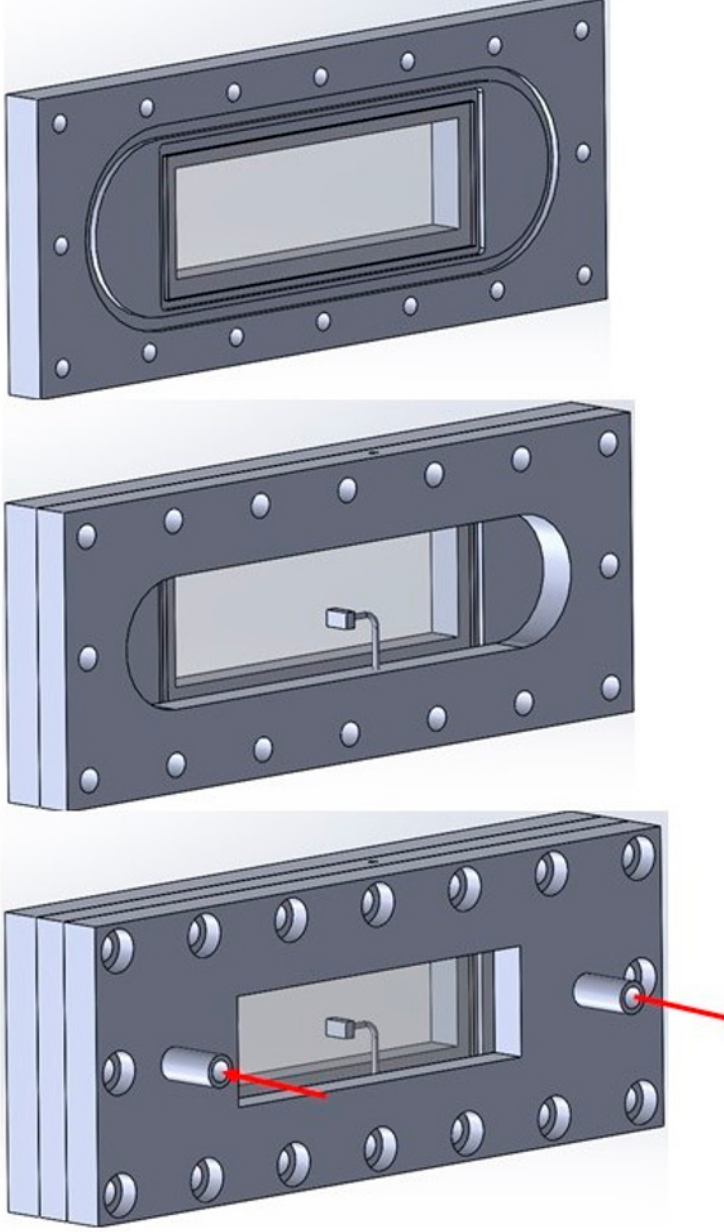
Figure 2. Flow-through cell with the crystal in the center of the channel and marked flow direction.